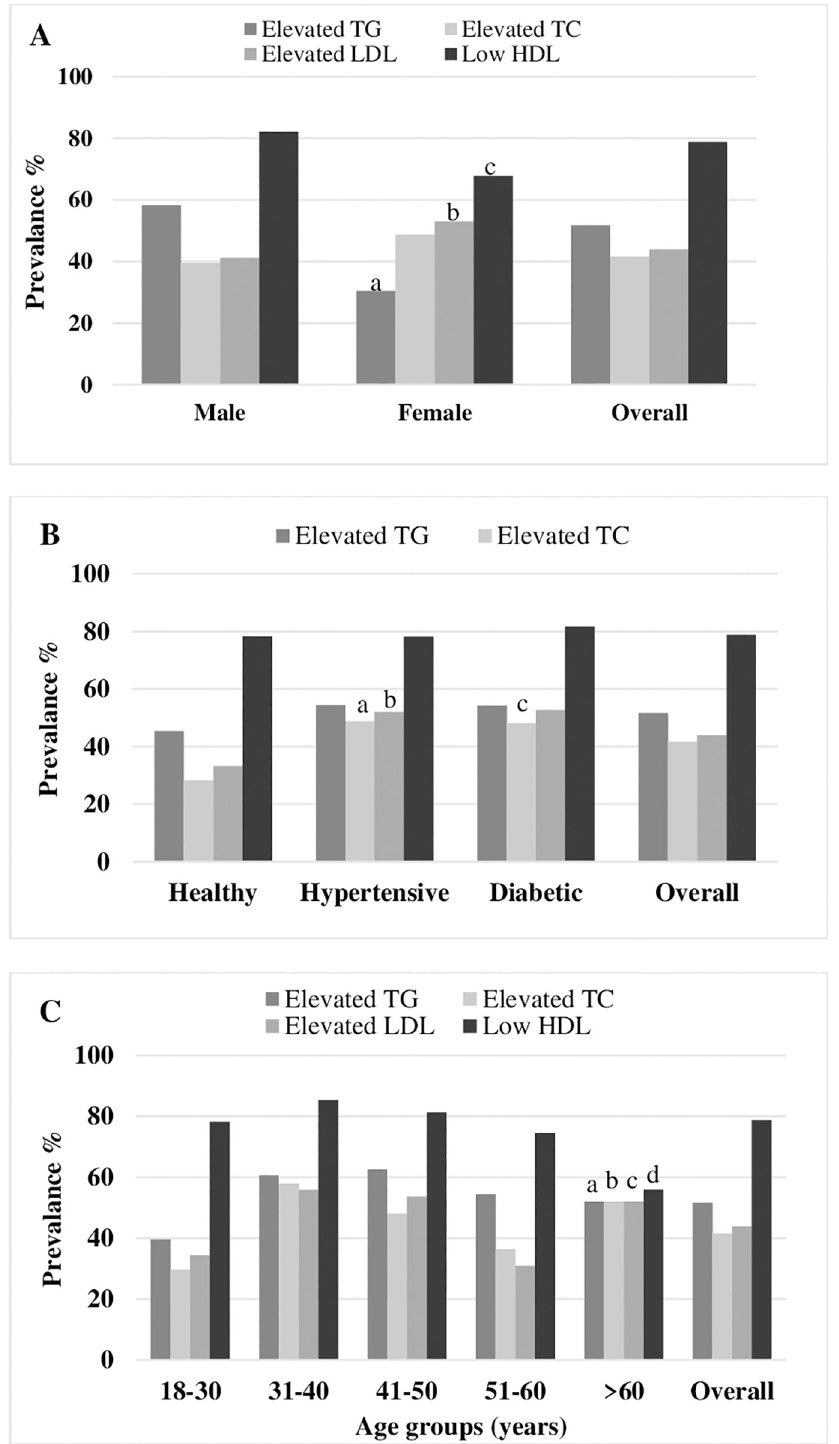
Fig 1. Prevalence of dyslipidemia in the gender (A), health status (B) and age (C) groups. In (A), a p < 0.001; b p < 0.05; c p < 0.01 when the prevalence in the female group is compared to the male group. In (B), a p < 0.01; b p < 0.001 and c p < 0.05 when the prevalence in hypertensive and diabetic groups are compared to the control group. In (C), a,b, c p < 0.001; d p < 0.05 when the prevalence in the > 60 years age group is compared to the lowest age group. P-values are derived from the Chi-square